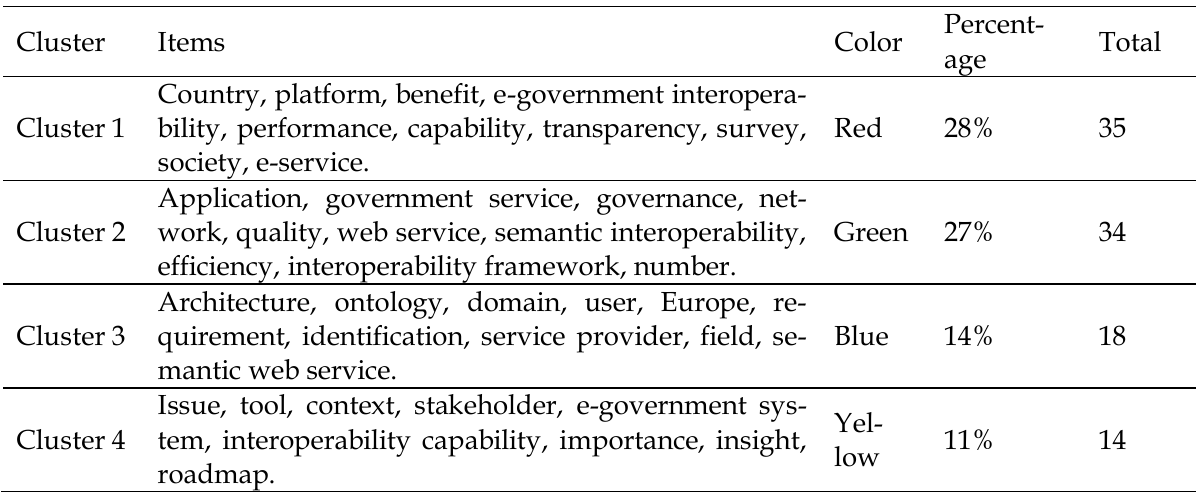
Table 5: Items by Cluster on Network Visualisation interoperability E-Government. Source: Processed by the author using